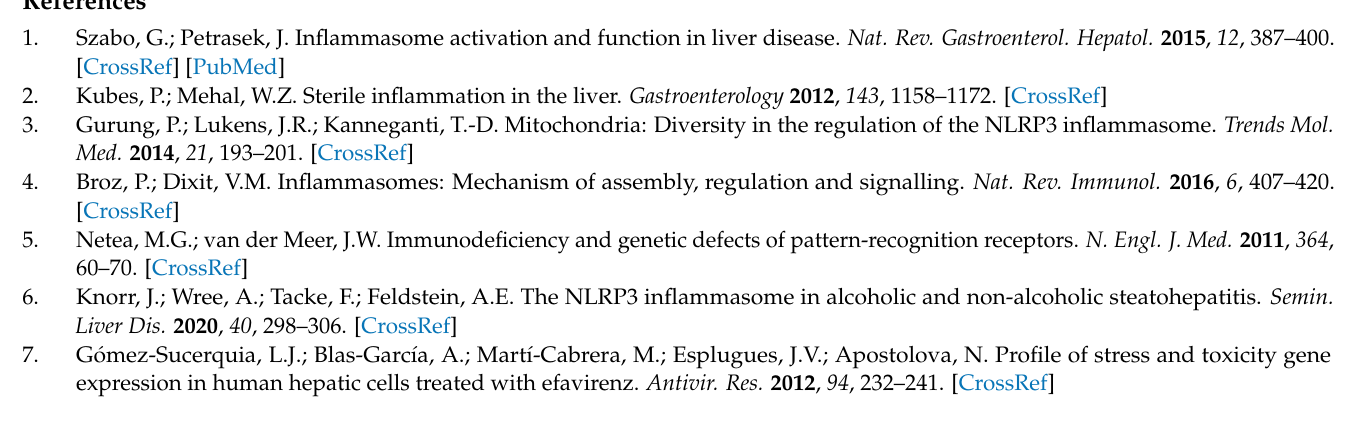
Table S1: Specific primary antibodies used for Western blot analysis, Table S2: Sequences of primers used for quantitative PCR, Figure S1: Efavirenz treatment upregulates pro-inflammatory markers in LX2 cells, Figure S2: Efavirenz treatment enhances expression of anti-inflammatory genes in U937-derived